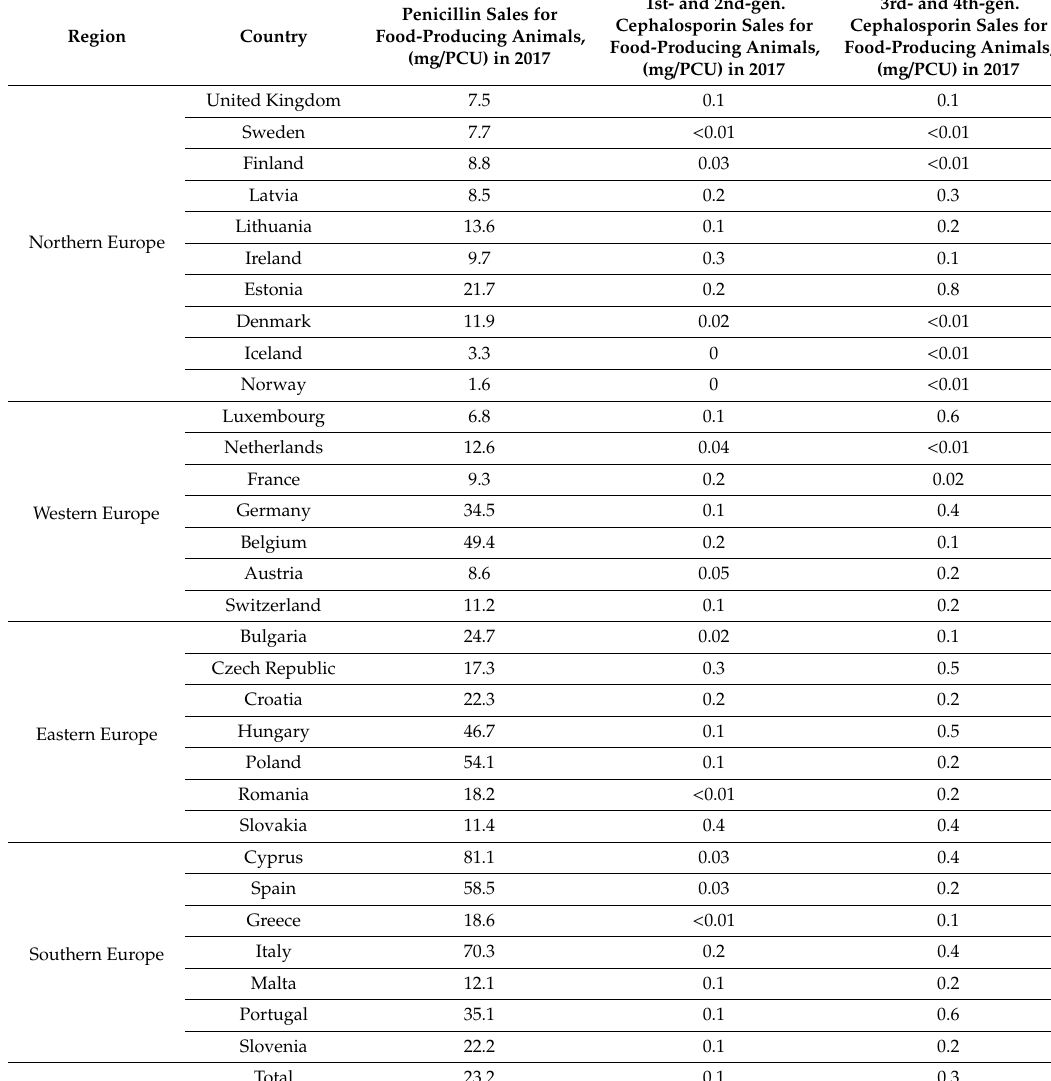
Table 2. Penicillin and cephalosporin sales in the EU for food-producing animals, in mg per population correction unit (mg / PCU) in 2017